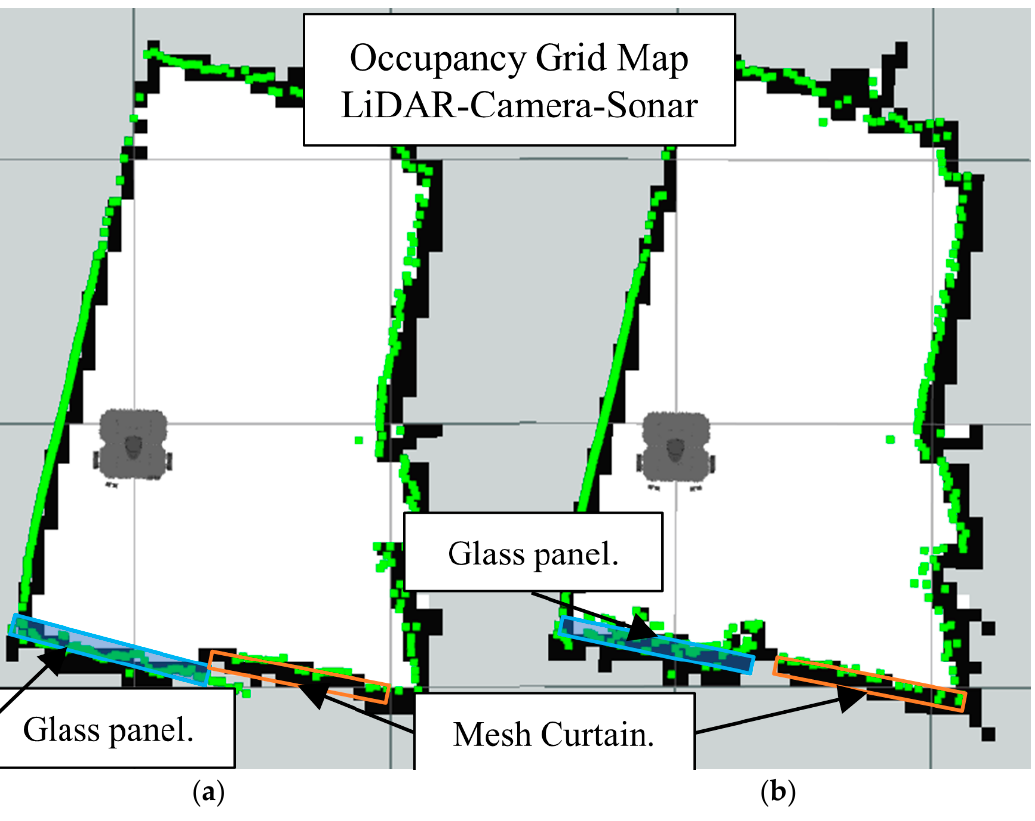
Figure 31. Occupancy grid maps showing the: ( a ) Ground truth (reference map); ( b ) LiDAR-Camara-Sonar fusion generated map with glass as main obstacle.